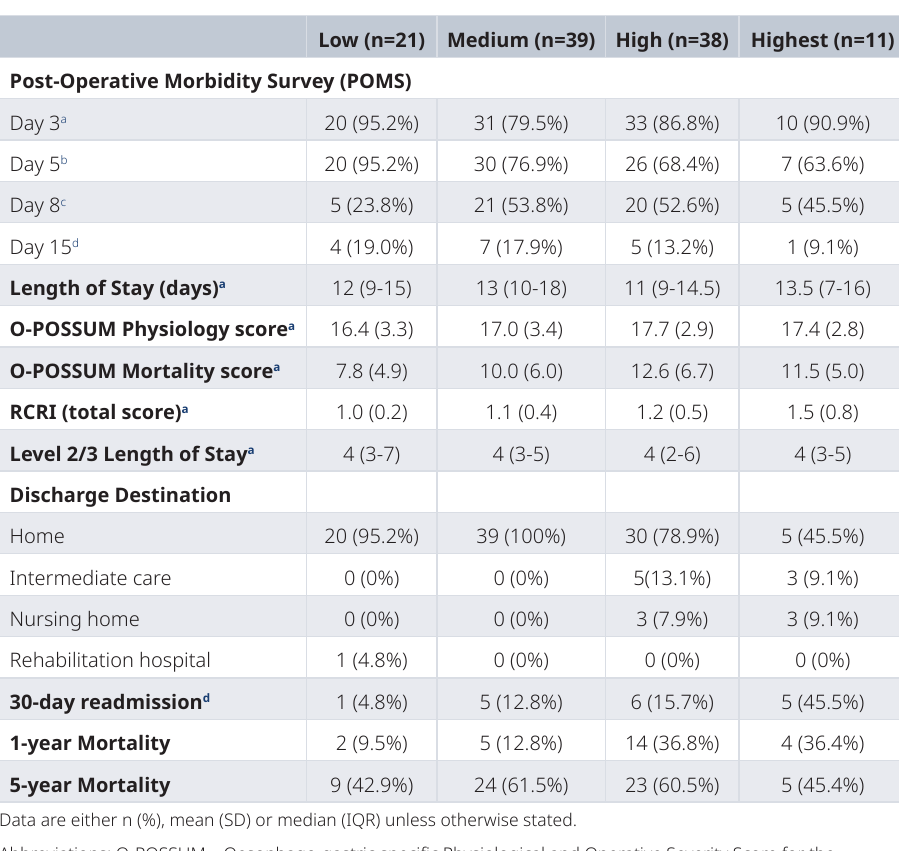
Table 5. Post-operative outcomes for low, medium, high and highest risk groups categorised by pre-chemotherapy/chemoradiotherapy oxygen uptake at anaerobic threshold (ml.kg -1 .min -1